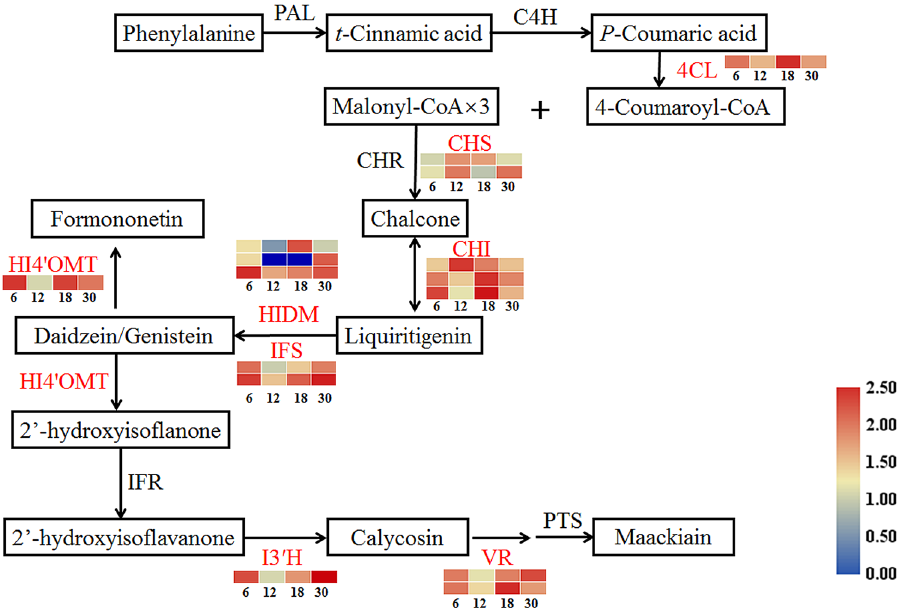
Figure 6. Expression profiles of DEGs involved in isoflavonoid metabolic pathway during C. speciosa root thickening. The log 10 -transformed FPKM expression values are shown. The numbers (6, 12, 18, 30) at the bottom of the heat maps represent the four different developmental ages. Changes in expression level are indicated by a change in color; from blue to red indicates an expression level from low to high. All data shown reflect the mean of three biological replicates ( n =